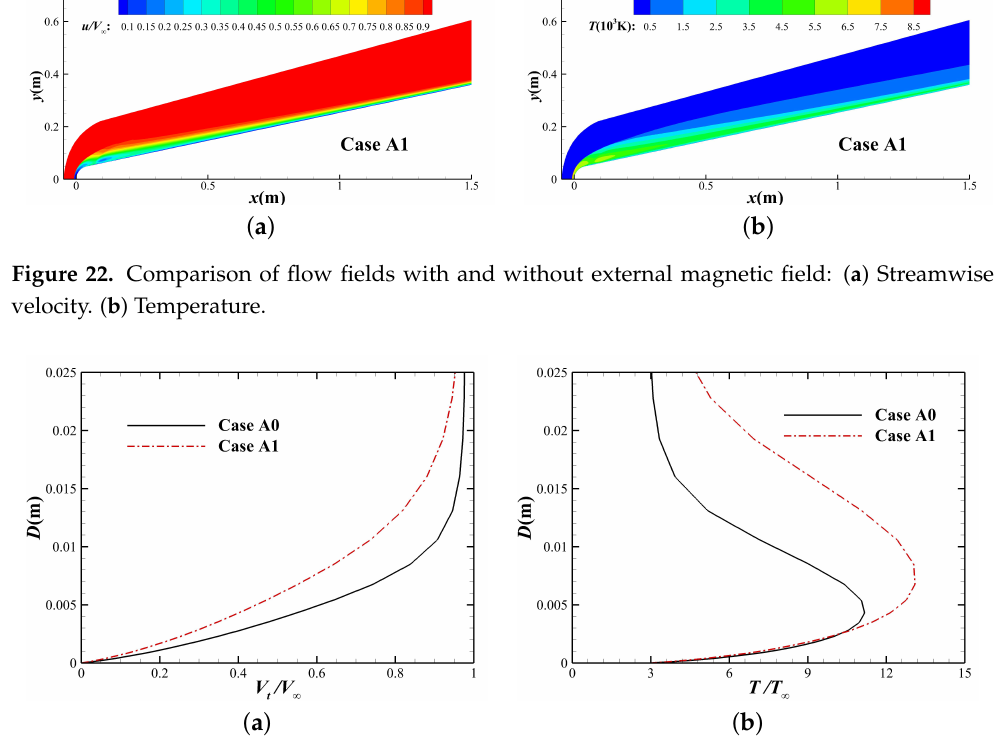
Figure 23. Boundary layer profiles at x = 1.5 m: ( a ) Streamwise velocity. ( b )